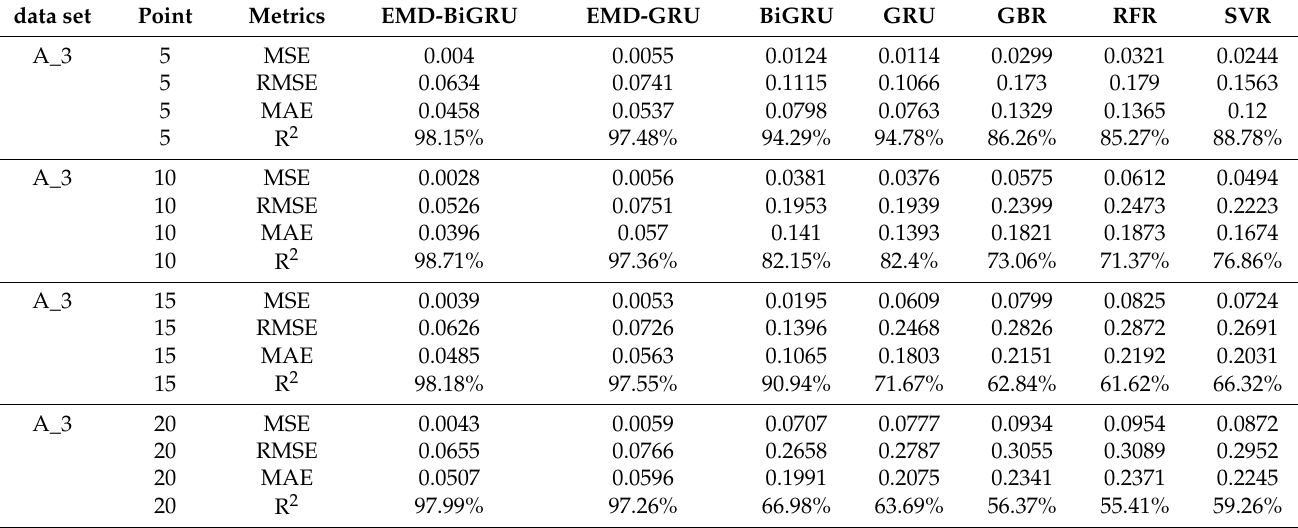
Table 2. Comparison results for data set A_3 using different algorithms.